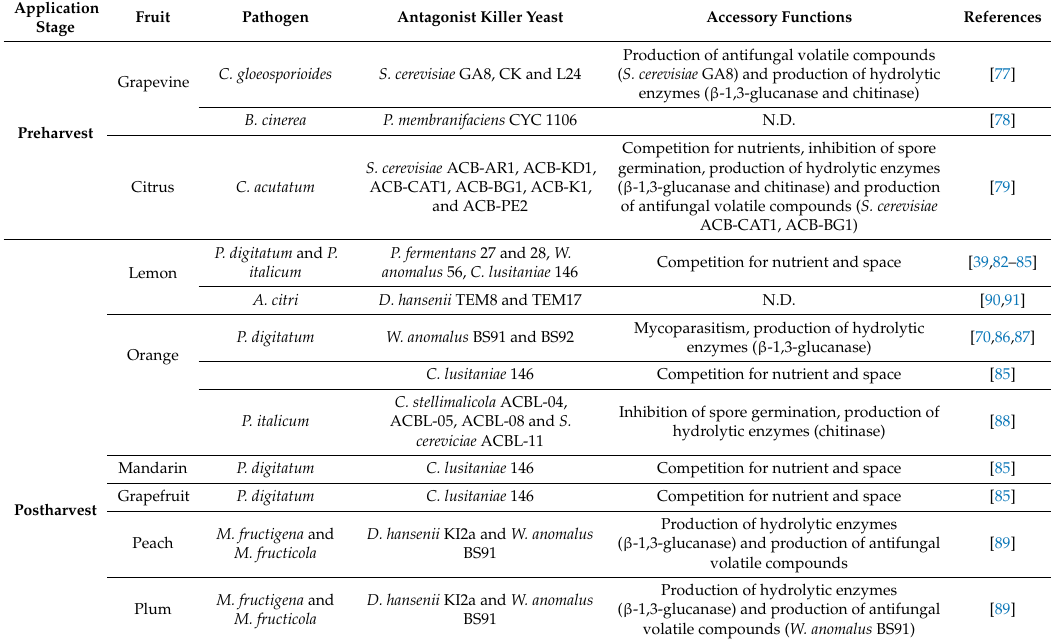
Table 1. Killer yeasts used as biological control agents in fruit (Figure